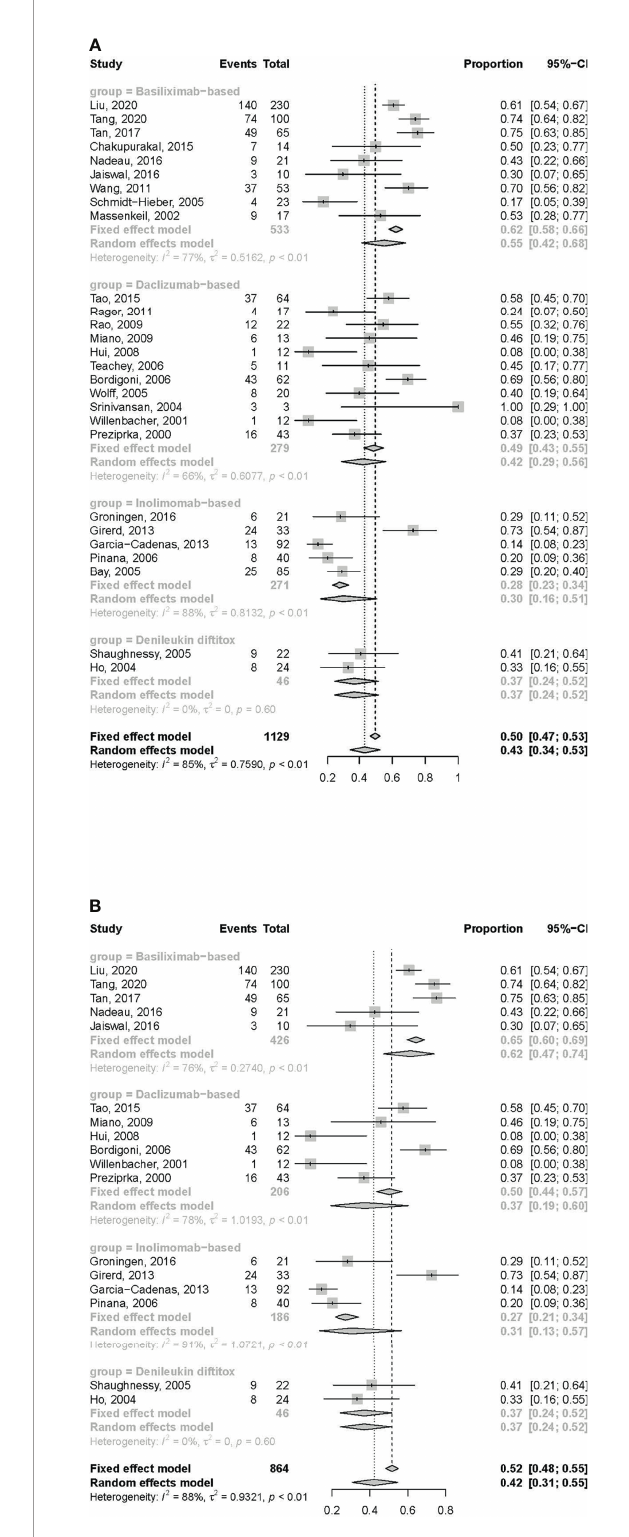
FIGURE 3 | Forest plots of CRR at any time (A) and 1 month (B) after treatment with